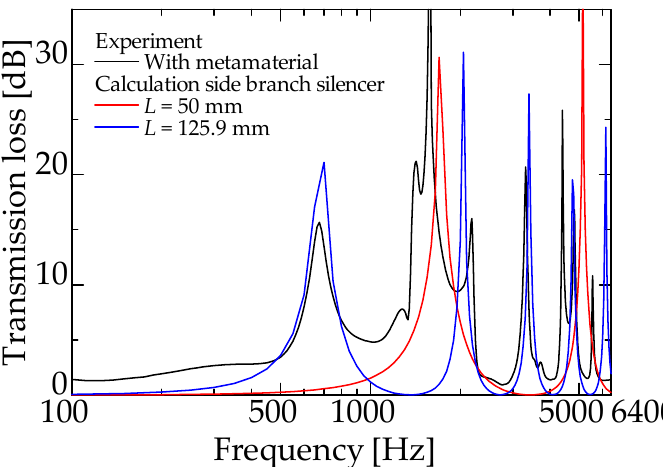
Figure 13. Comparison with simple side-branch silencer (experimental: interference silencer with zero-mass metamaterial; theoretical: side-branch silencer with 50 mm and 125.9 mm branch tube length).